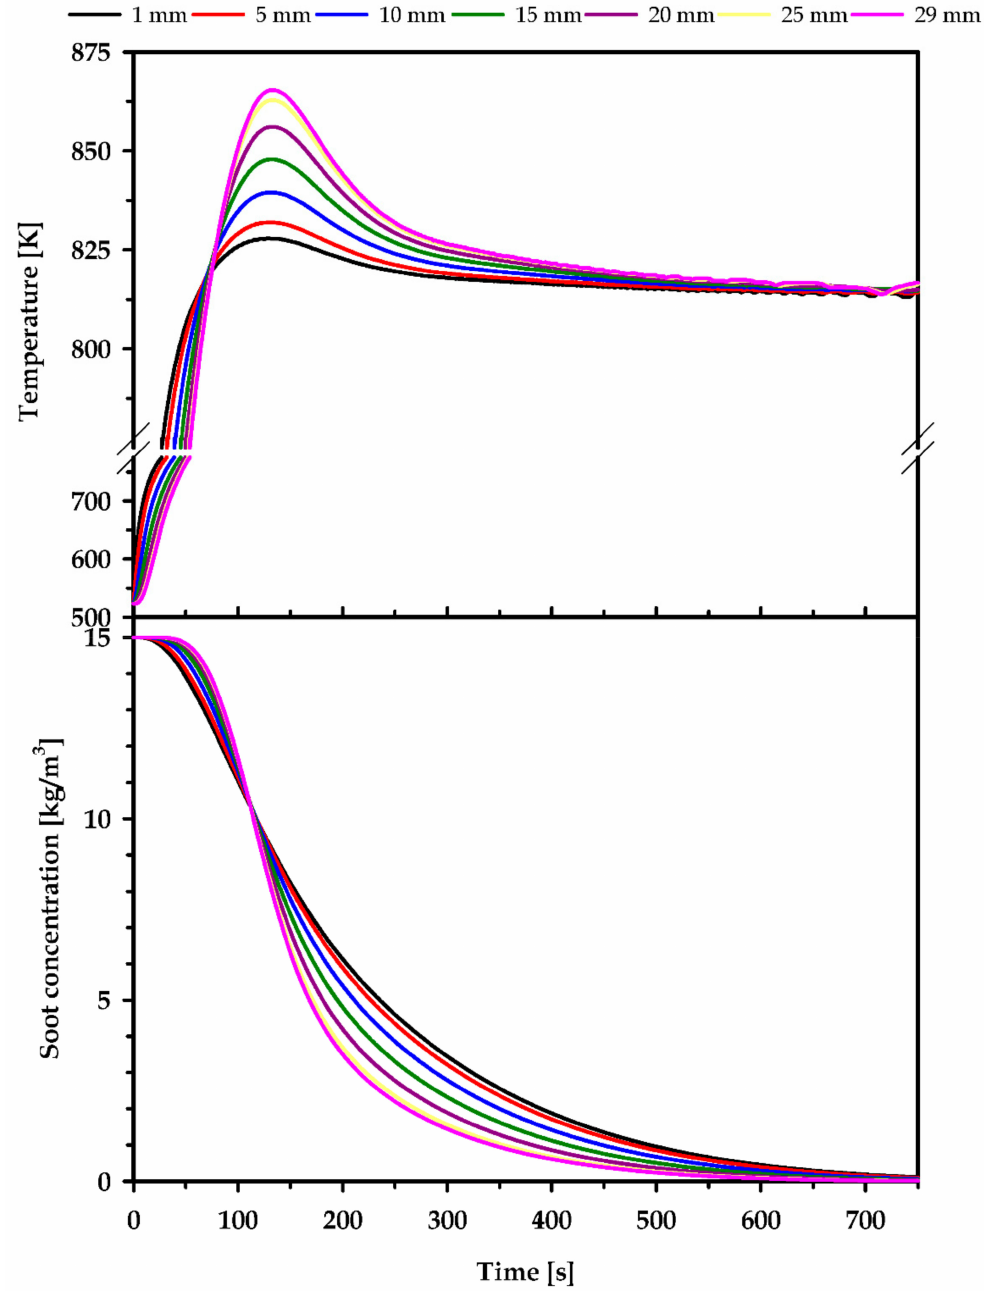
Figure 3. Time histories of temperature and soot concentration (monitor points of Figure 2): k = 1 (from Reference